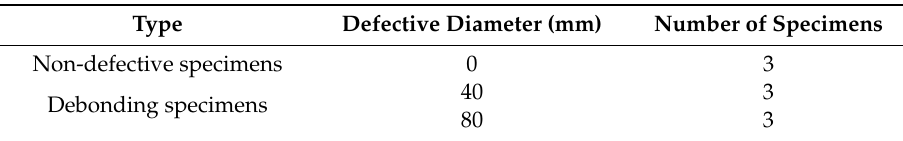
Table 5. Test Table 5. Test matrix.